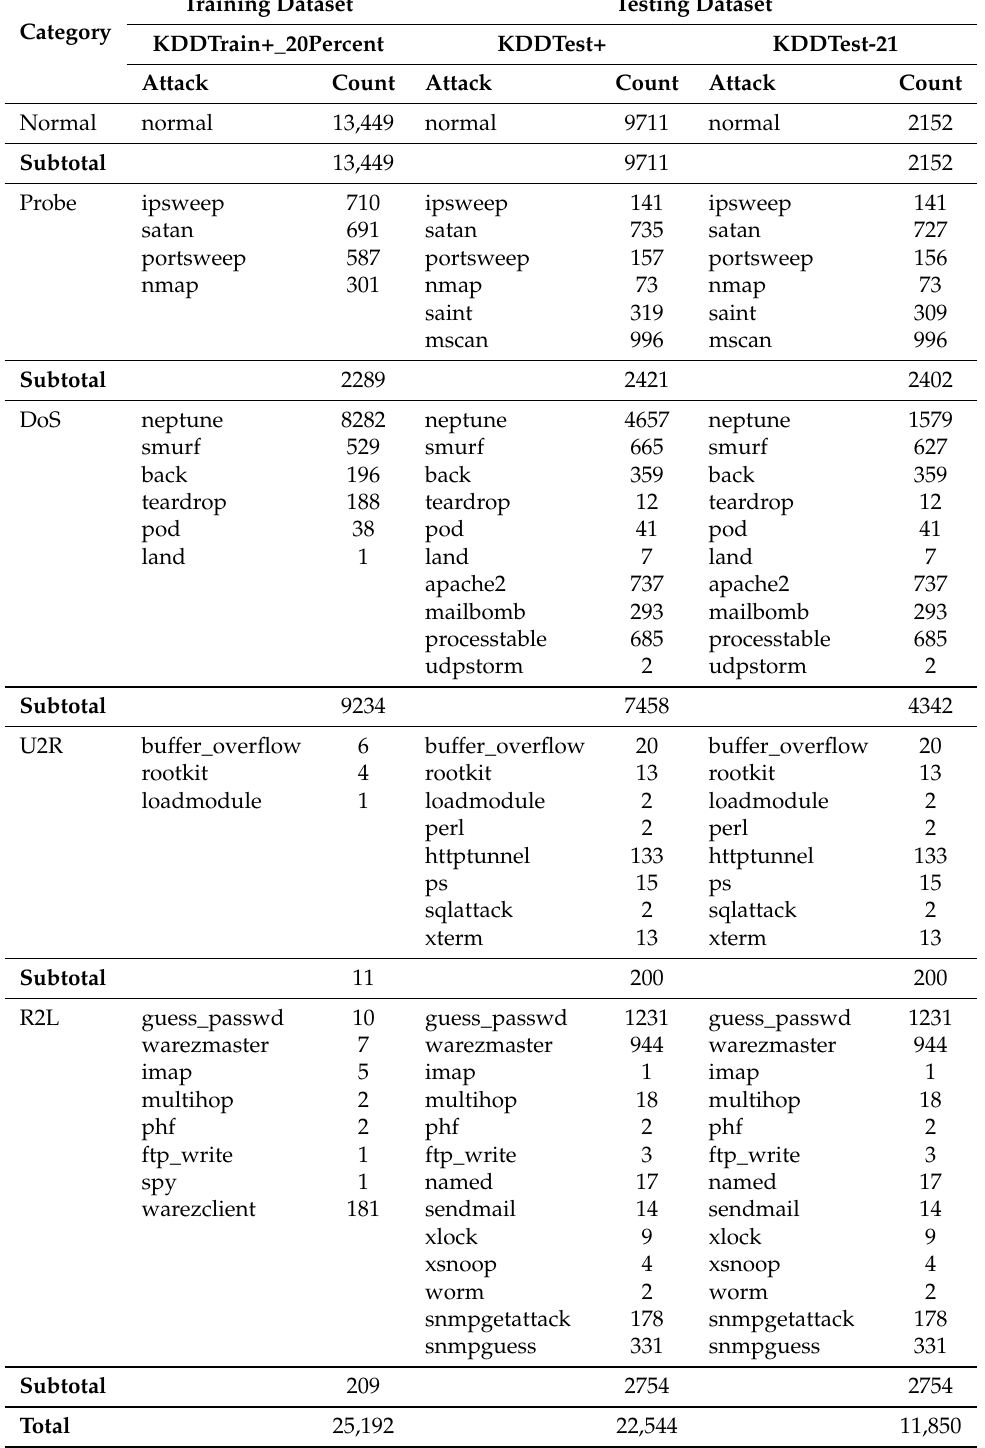
Table 2. The class distribution of the NSL-KDD